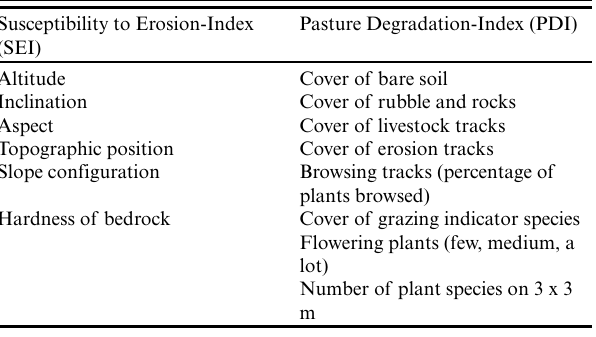
Pasture Degradation-Index (PDI)